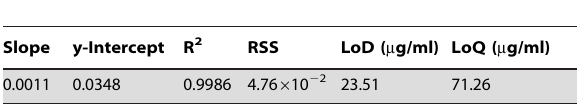
Table 2. Properties of the mean calibration plot for quantification of BSA (N